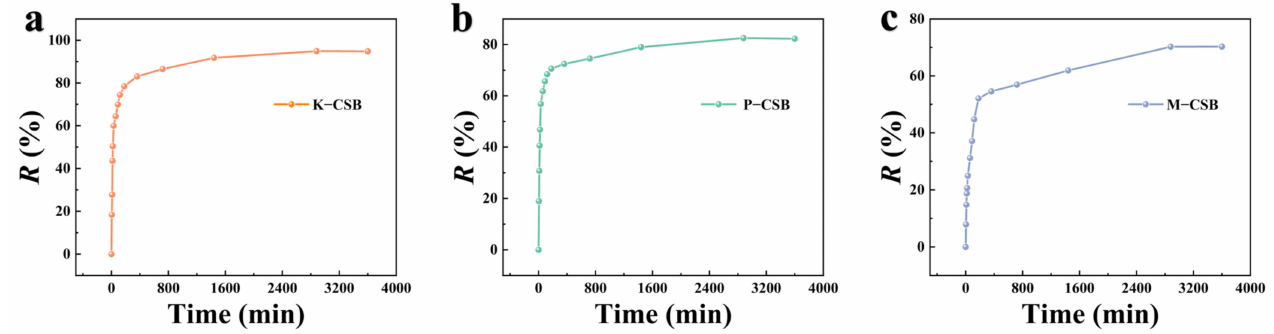
Figure 8. The effect of time on 400 mg/L TC adsorption by modified biochar (( a ) is K − CSB; ( b ) is P − CSB; and ( c ) is M − CSB).